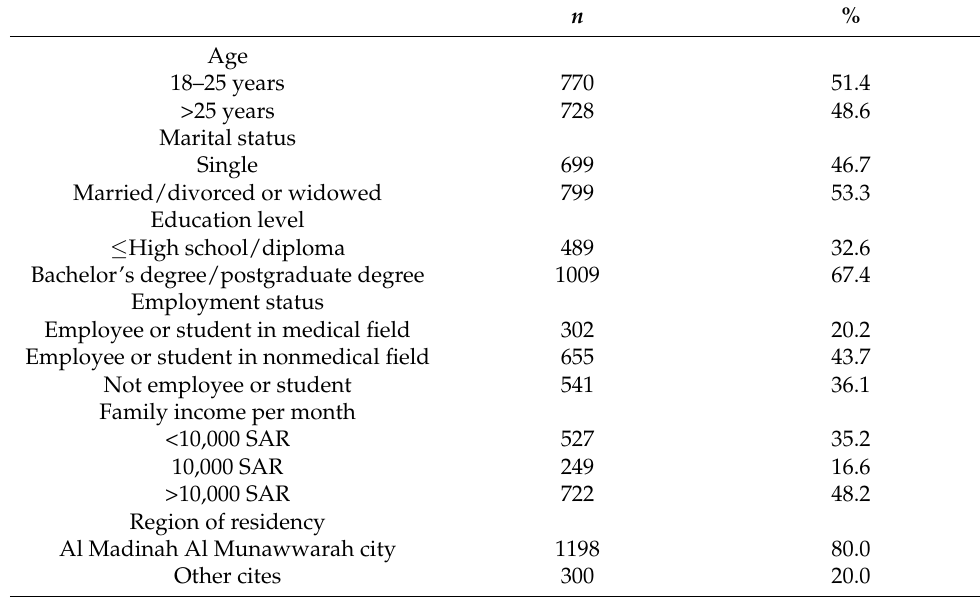
Table 1. Characteristics of the study participants ( n =